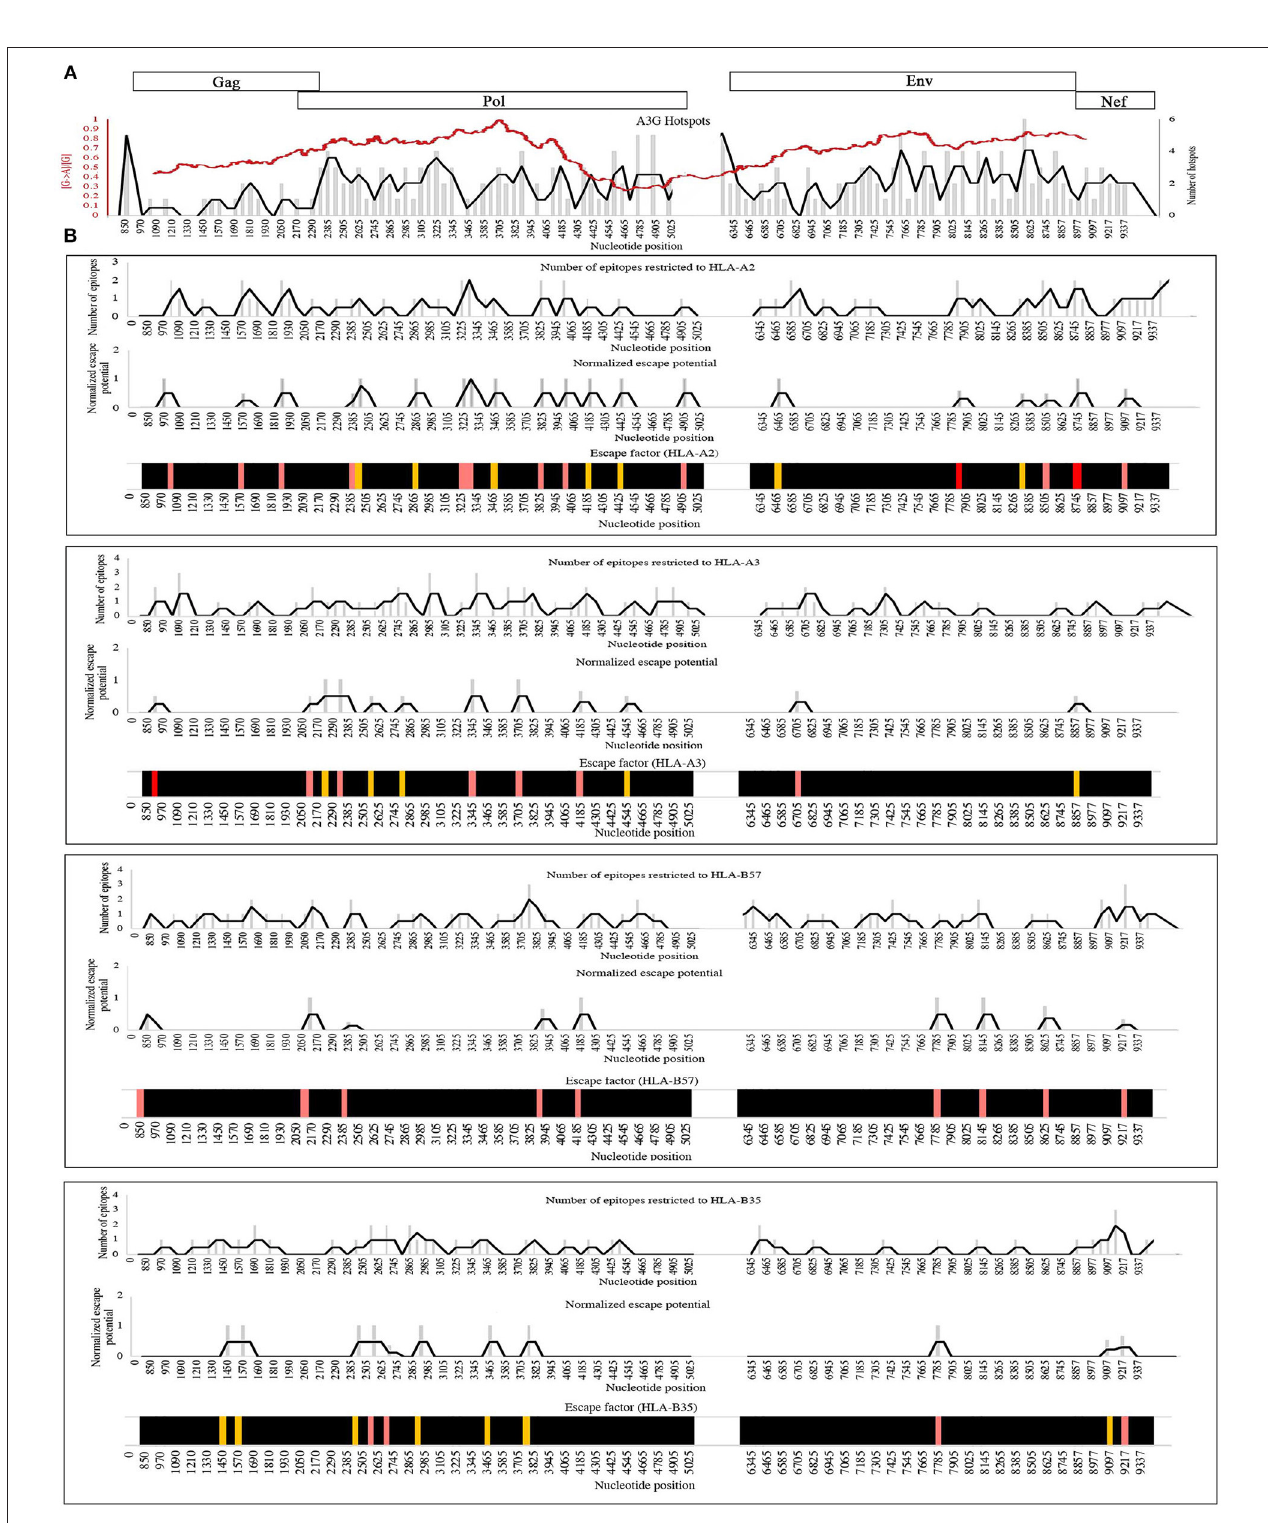
FIGURE 4 | Distribution pattern of CTL escape-inducing A3G hotspots in the context of the entire HIV genome and its mutational gradient. (A) To analyze the distribution pattern of A3G hotspots across the HIV genome, we counted the number of A3G hotpots that could result in non-synonymous amino acid changes within windows of 60 bp length across the entire length of Gag, Pol, Env, and Nef. The number of A3G hotspots in each 60 bp window is plotted as gray bars, and the overall pattern is shown as a black line. We then overlaid this pattern against the known mutational gradient of the HIV genome as previously described (red line)